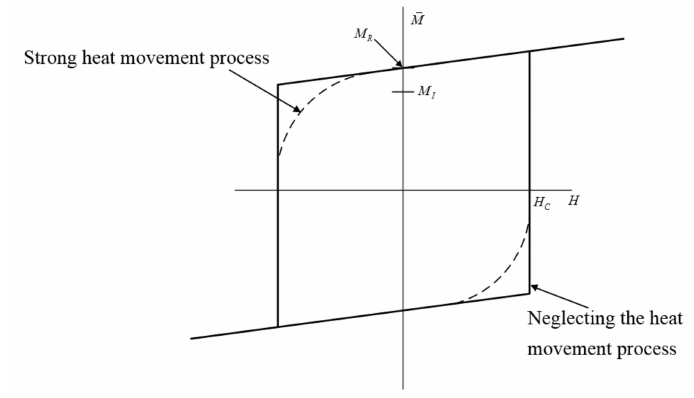
Figure 5. Relationship between magnetization M and magnetic field strength H